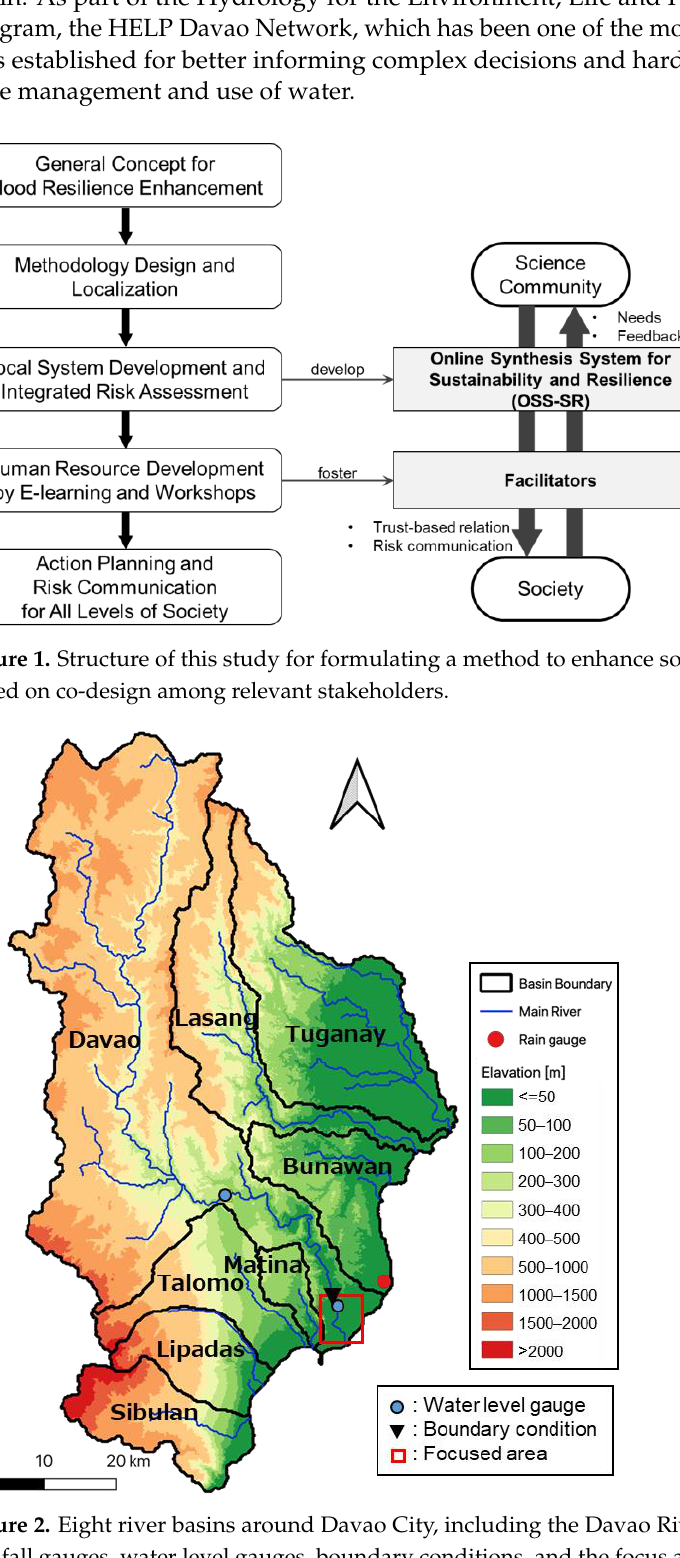
Figure 2. Eight river basins around Davao City, including the Davao River basin. The locations of rainfall gauges, water level gauges, boundary conditions, and the focus area are also